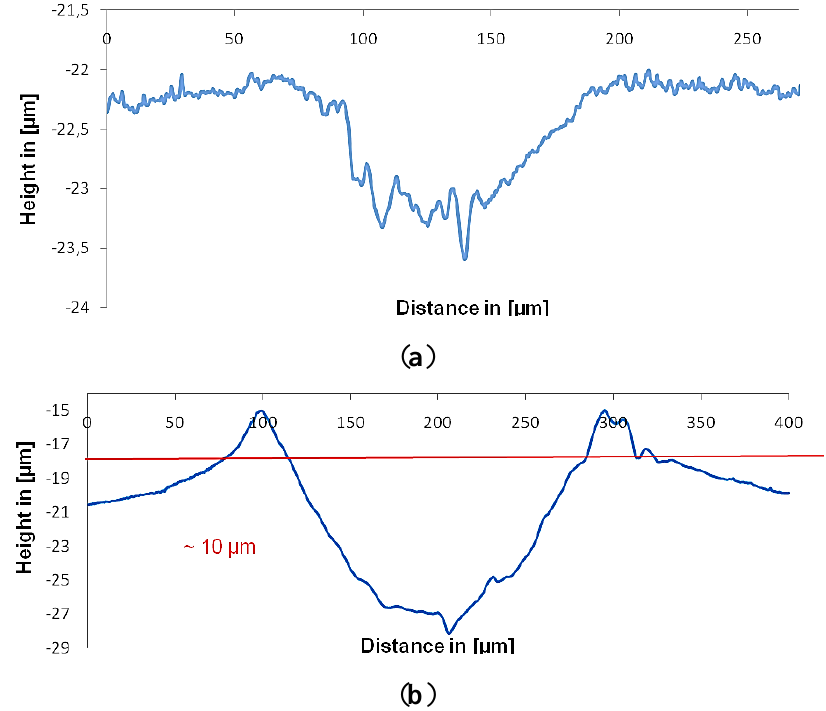
Figure 6. ( a ) Wear track profile from coating DLC-Si-316L-07; ( b ) Wear track profile from coating